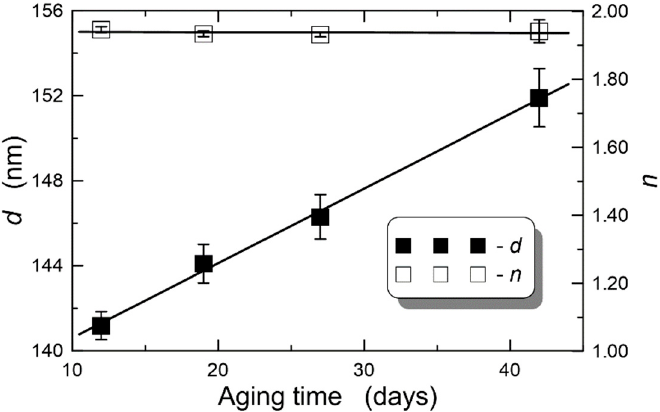
Figure 7. Influence of sol aging time on film thickness and refractive index for withdrawal speed of substrates from sol v = 5.0 cm/min. λ = 632.8